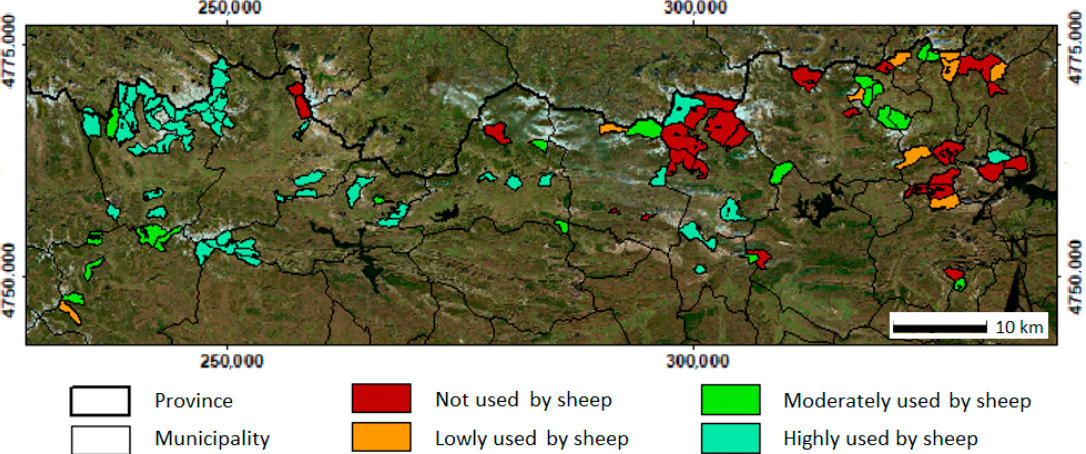
Figure 4. Map showing the classification of merino passes according to their time of use by sheep during the period 1990–2020, determined by the number of years they have received sheep flocks. Reference system: ETRS1989 UTM Zone 30N.